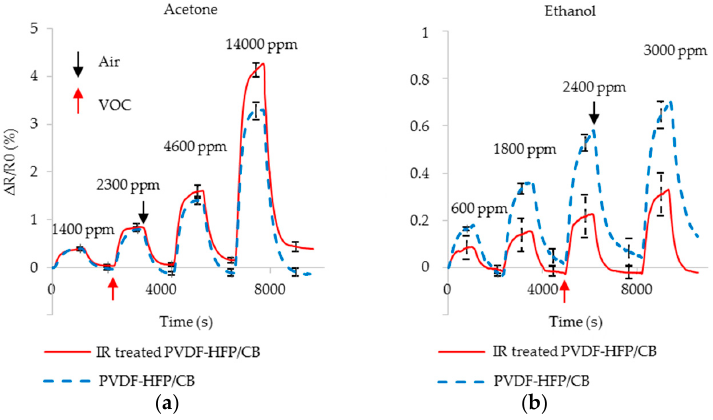
Figure 11. Resistance change of the IR treated (red solid) and non-treated (blue dotted) PVDF-HFP/CB sensors due to the exposure to various concentration of ( a ) acetone; ( b ) ethanol.